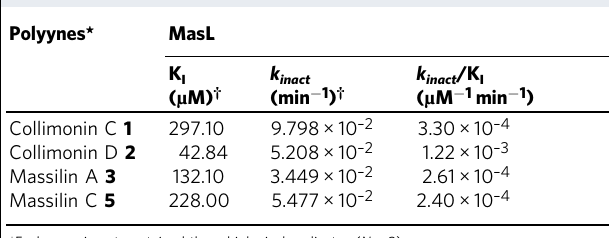
*Each experiment contained three biological replicates ( N = 3). † Full data was illustrated in Supplementary Fig.